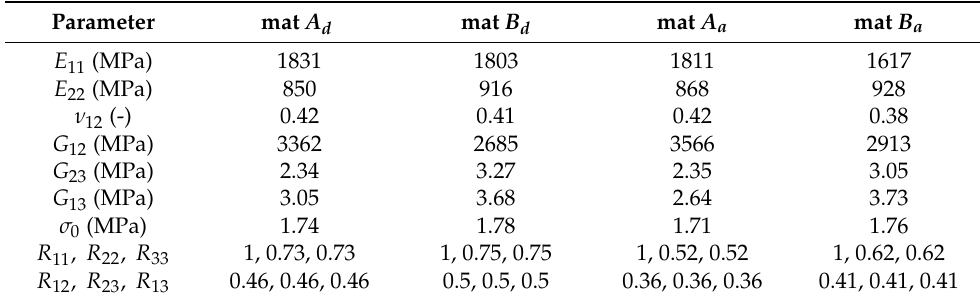
Table 7. Material parameters in four different constitutive models. The subscript “d” refers to a digital finishing process while “a” refers to an analog finishing process.